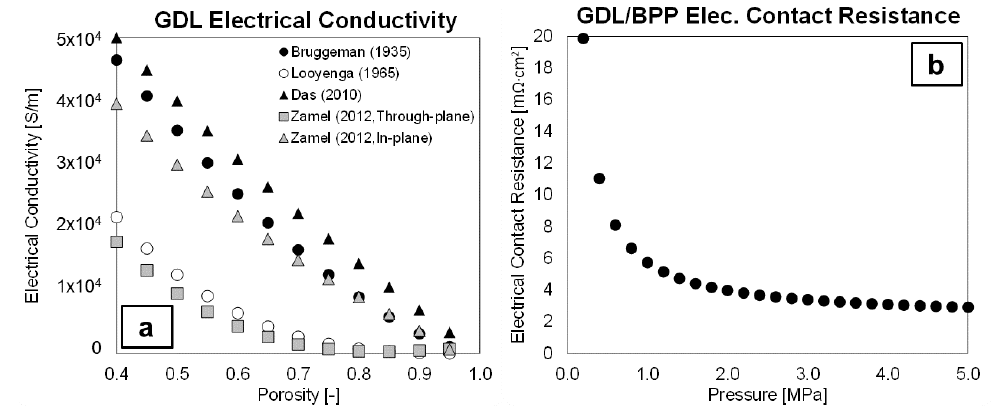
Figure 3. Left ( a ): Correlations for GDL electrical conductivity κ ef f from Table 7 as a function of the GDL porosity (cid:101) using κ s = 1 × 10 5 [S/m]. Right ( b ): Correlation for GDL/BPP ECR from Table 8 as a function of the sealing